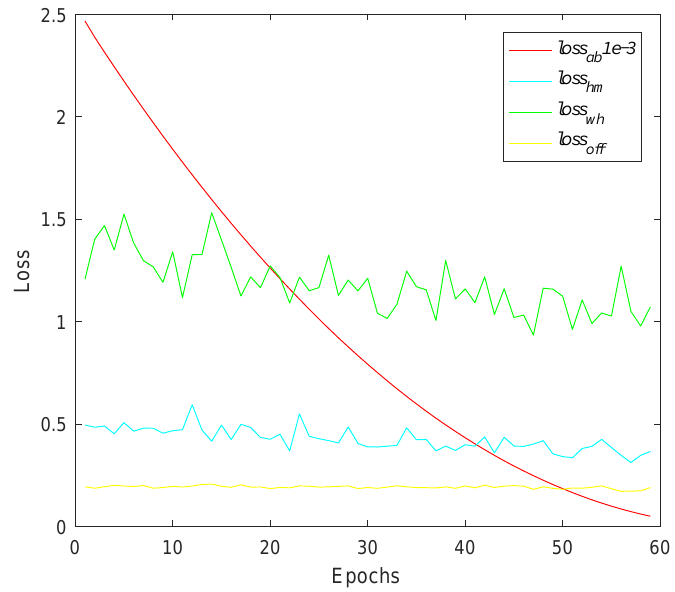
Figure 6. Changes in training loss during absorption training on SSDD.